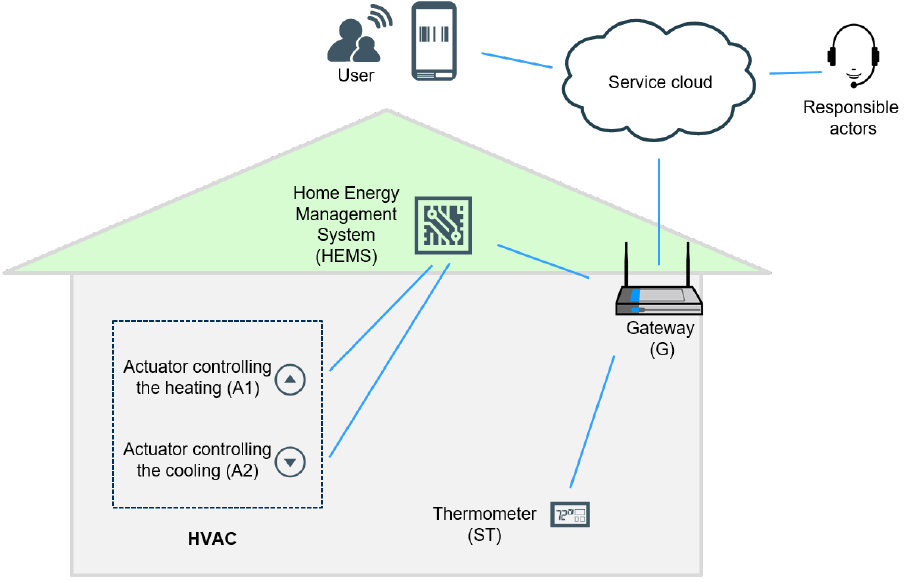
Figure 7. Smart home and HVAC hijacking use-case